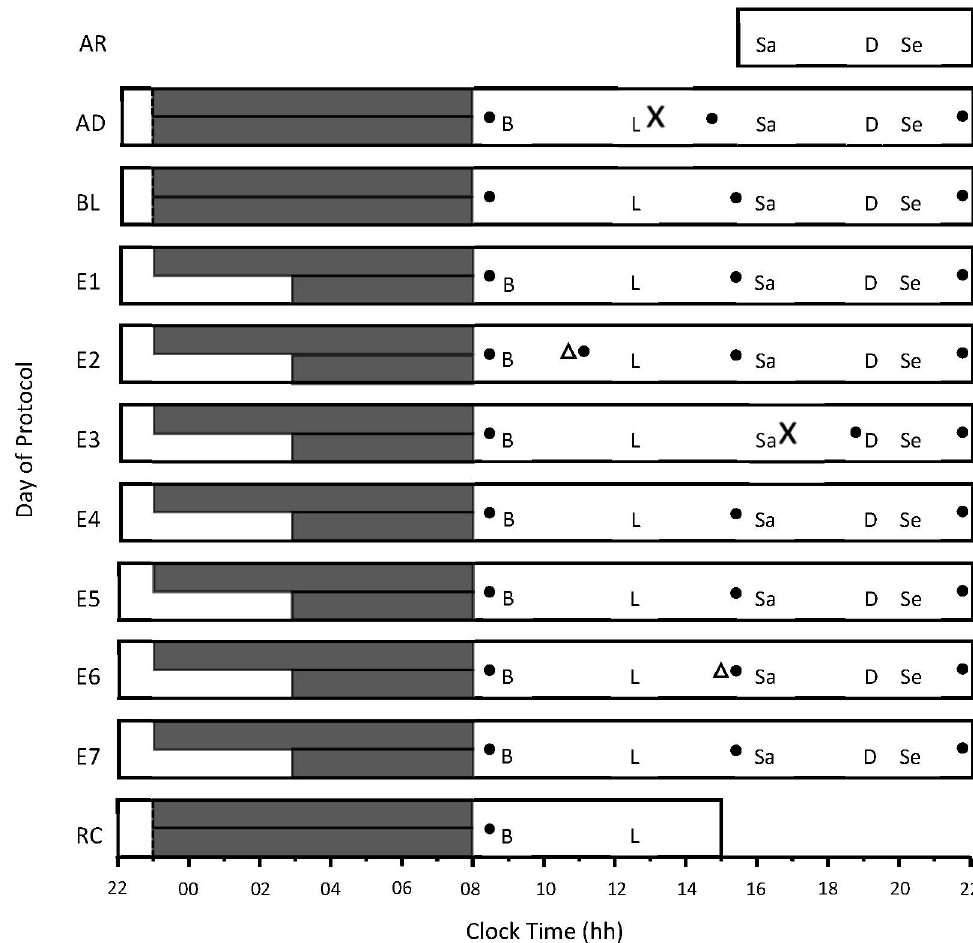
Figure 1. Study protocol. The x -axis indicates time of day, from 22:00 h to 22:00 h. The y -axis indicates the day of the protocol, including AR = arrival day, AD = adaptation day, and BL = baseline day. E1 to E7 = experimental days 1 to 7, and RC = recovery day. The long and short solid dark gray bars represent time in bed for the 9 h and the 5 h conditions, respectively. Meals and snacks were served at the same time each day—B = breakfast, L = lunch, Sa = afternoon snack, and Se = evening snack. ‘X’ indicates when the first and second continuous glucose-monitoring sensors were inserted, and the solid black circles represent capillary-blood-testing times for device calibration. Triangles represent when the sensors were restarted to ensure their continued function beyond 72 h of wear.